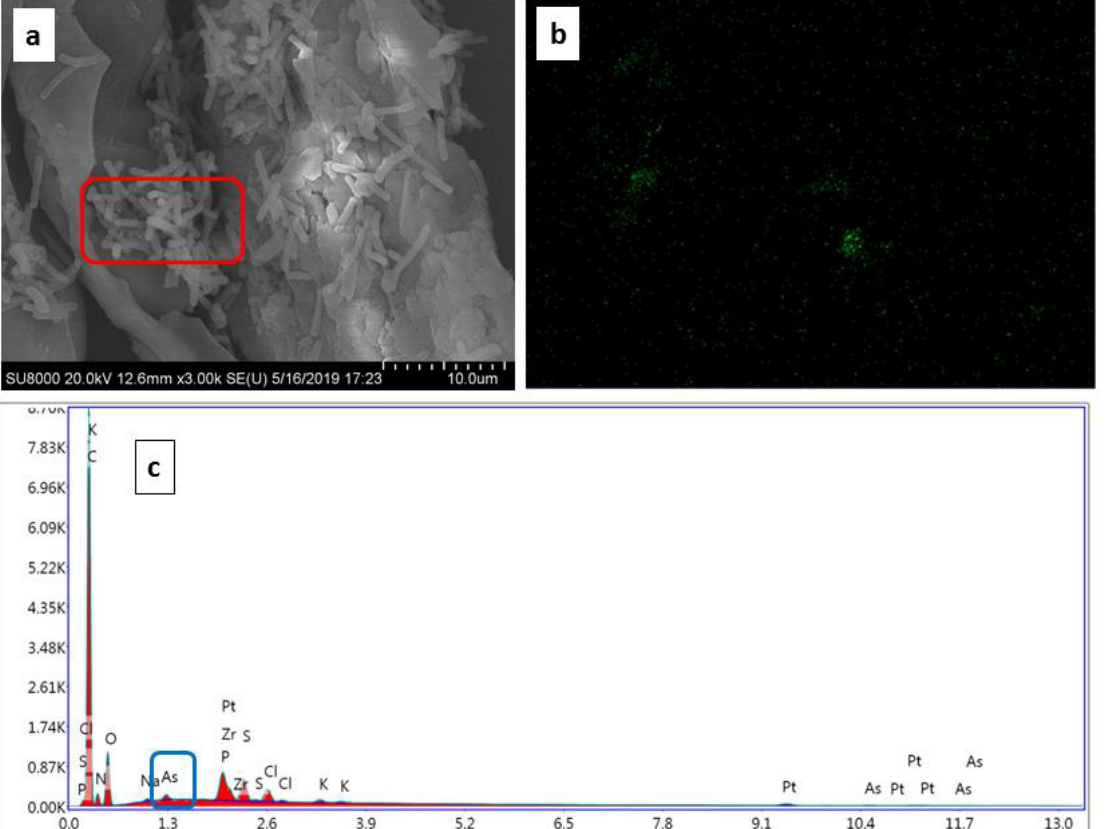
Figure 5. ( a ) SEM micrograph of biochar and ( b ) EDX graph of biochar after arsenic adsorption at optimized conditions. 3.6. FTIR Spectra of BCXZM Composite after Arsenic Adsorption